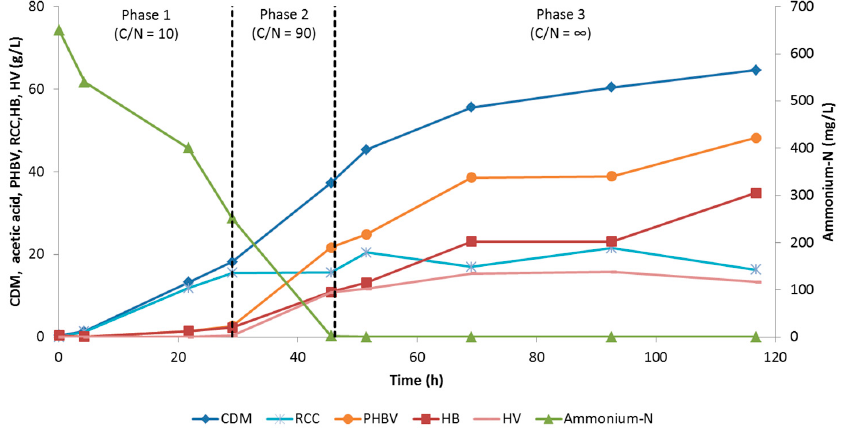
Figure 4. Fed-batch fermentation of C. necator for PHBV production using acetic acid and valeric acid as carbon source. The accumulation of biomass (CDM), PHB, residual cell concentration (RCC), acetic acid and valeric acid concentration over time of fermentation are shown. A three-phase feeding strategy was applied.